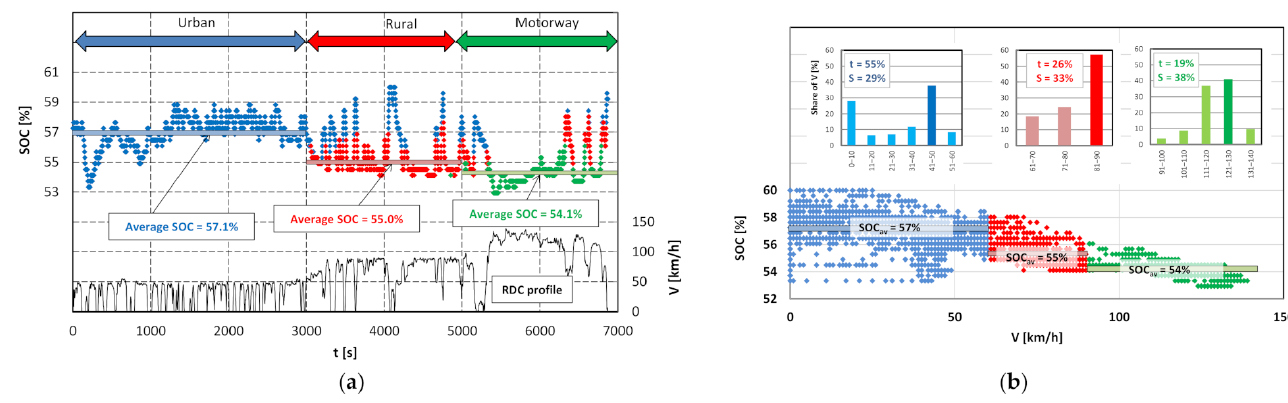
Figure 5. Changes in battery SOC: ( a ) with averaged values for travel phases; ( b ) in relation to travel